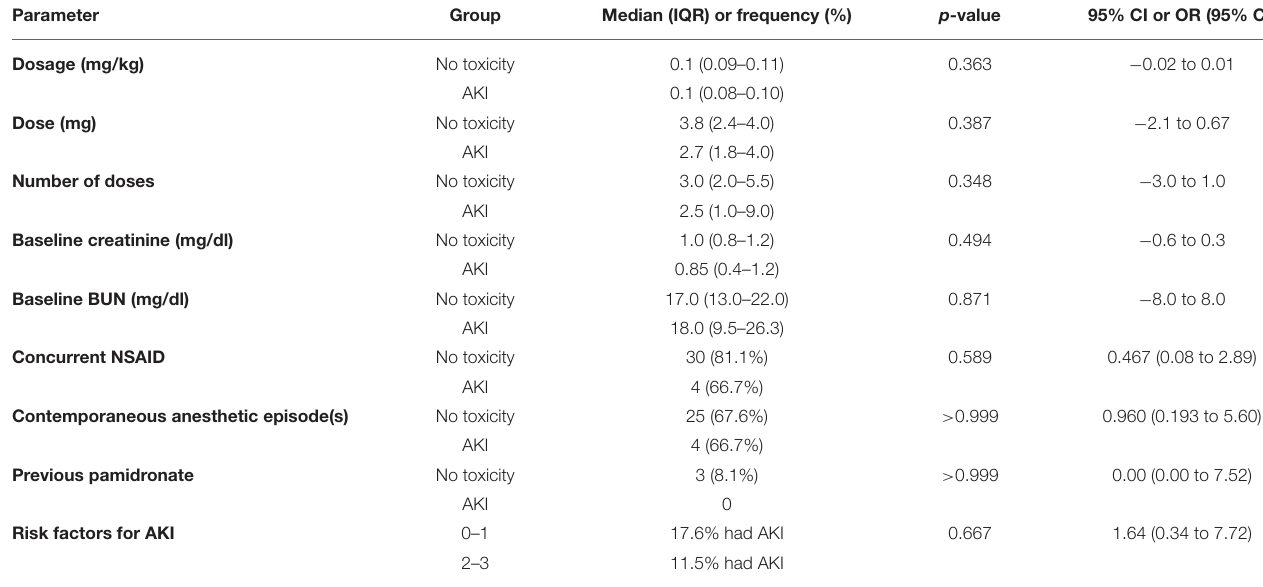
TABLE 3 | Comparison of various parameters between 37 dogs without renal toxicity and 6 dogs non-azotemic at baseline with documented AKI following zoledronic acid administration.